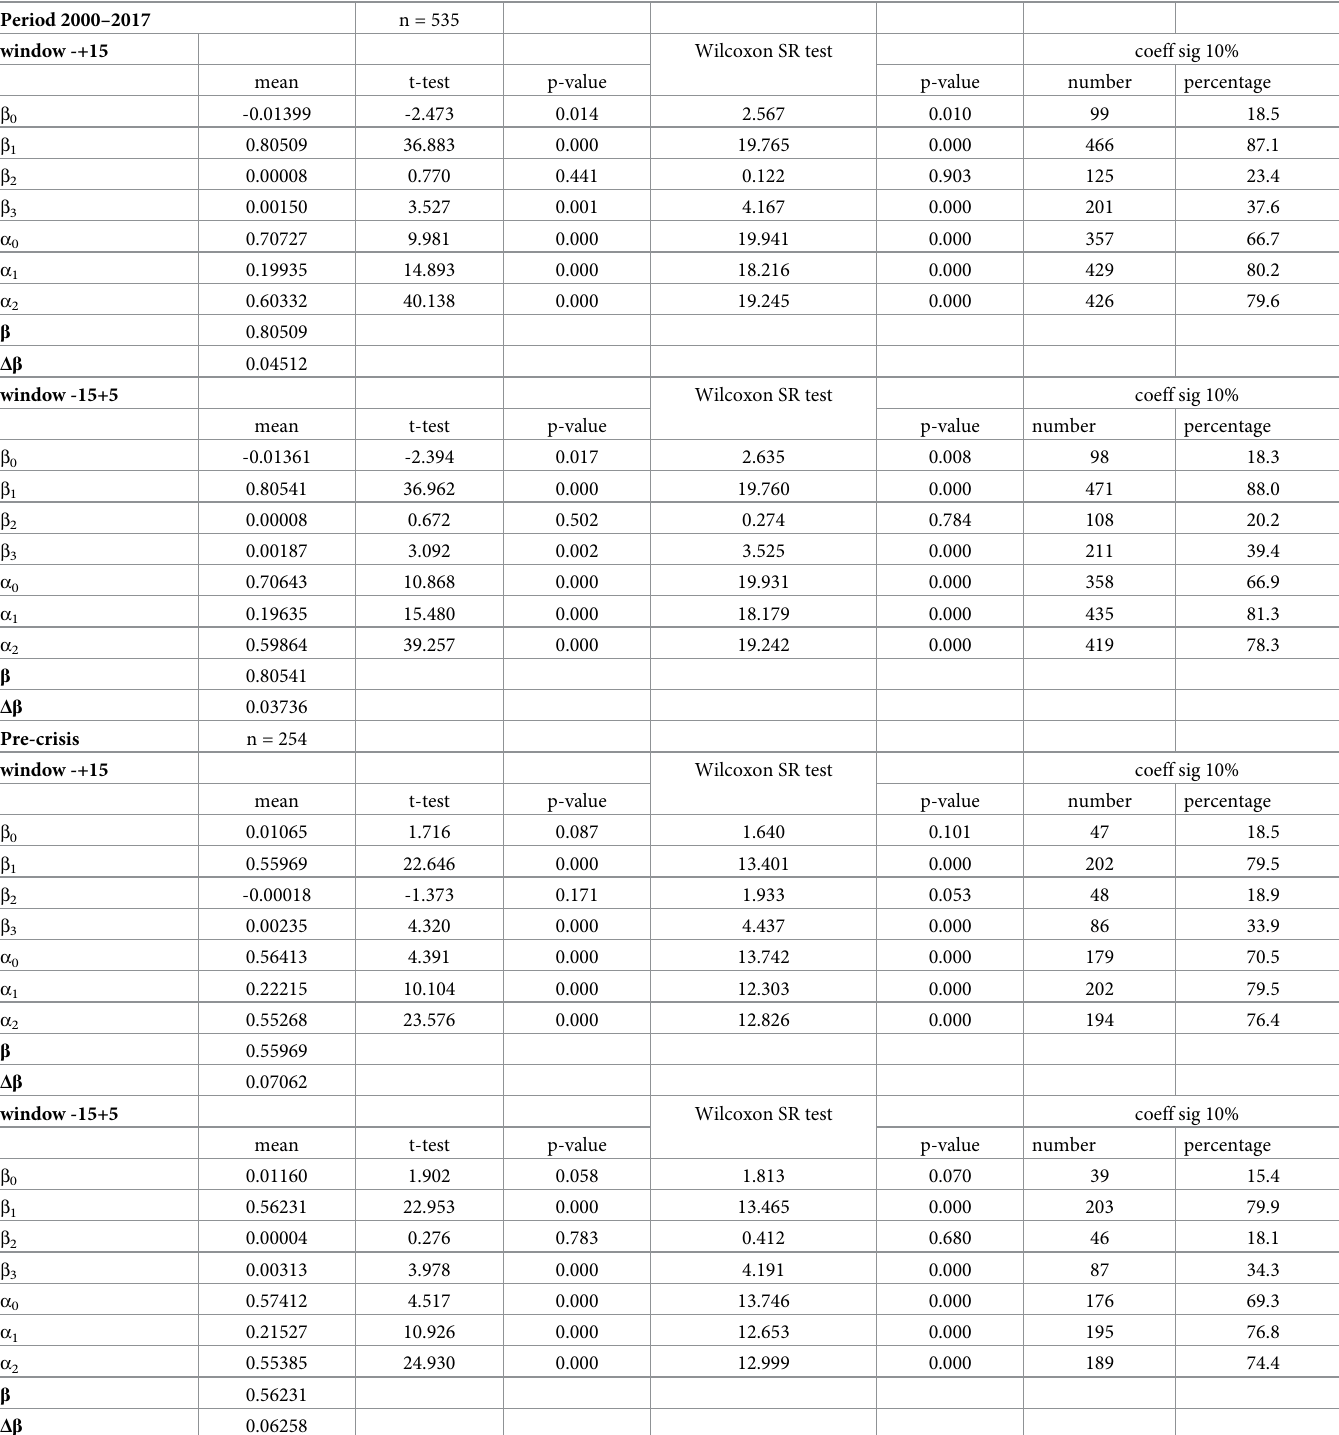
Table 3. Summary results: